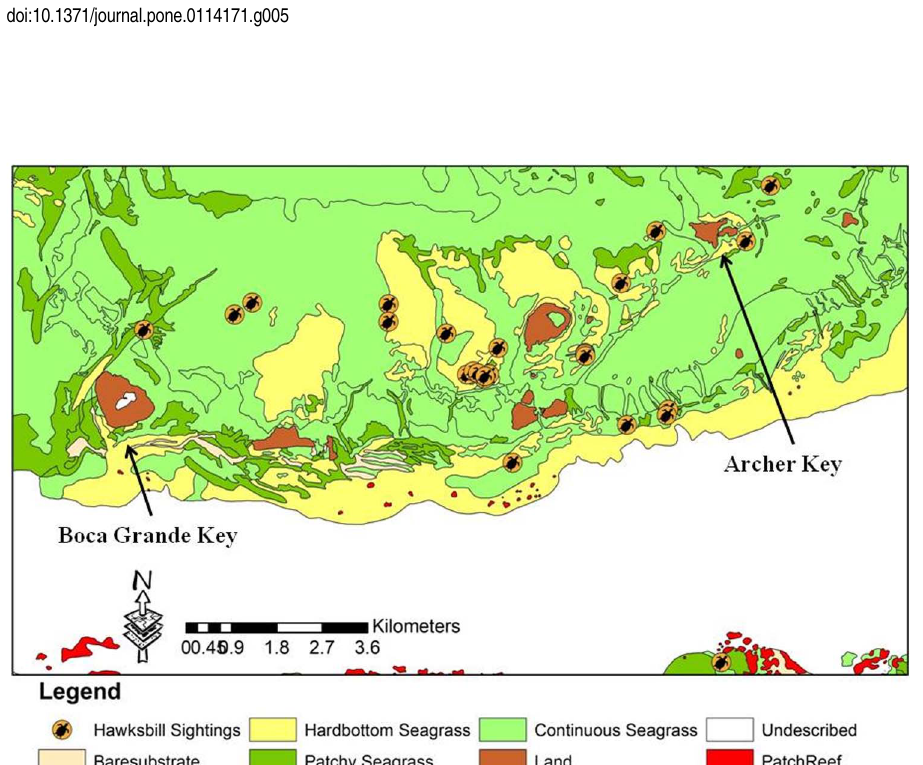
Fig. 5. Hawksbill turtle sighting locations in the northeast KWNWR, 2001–2011.